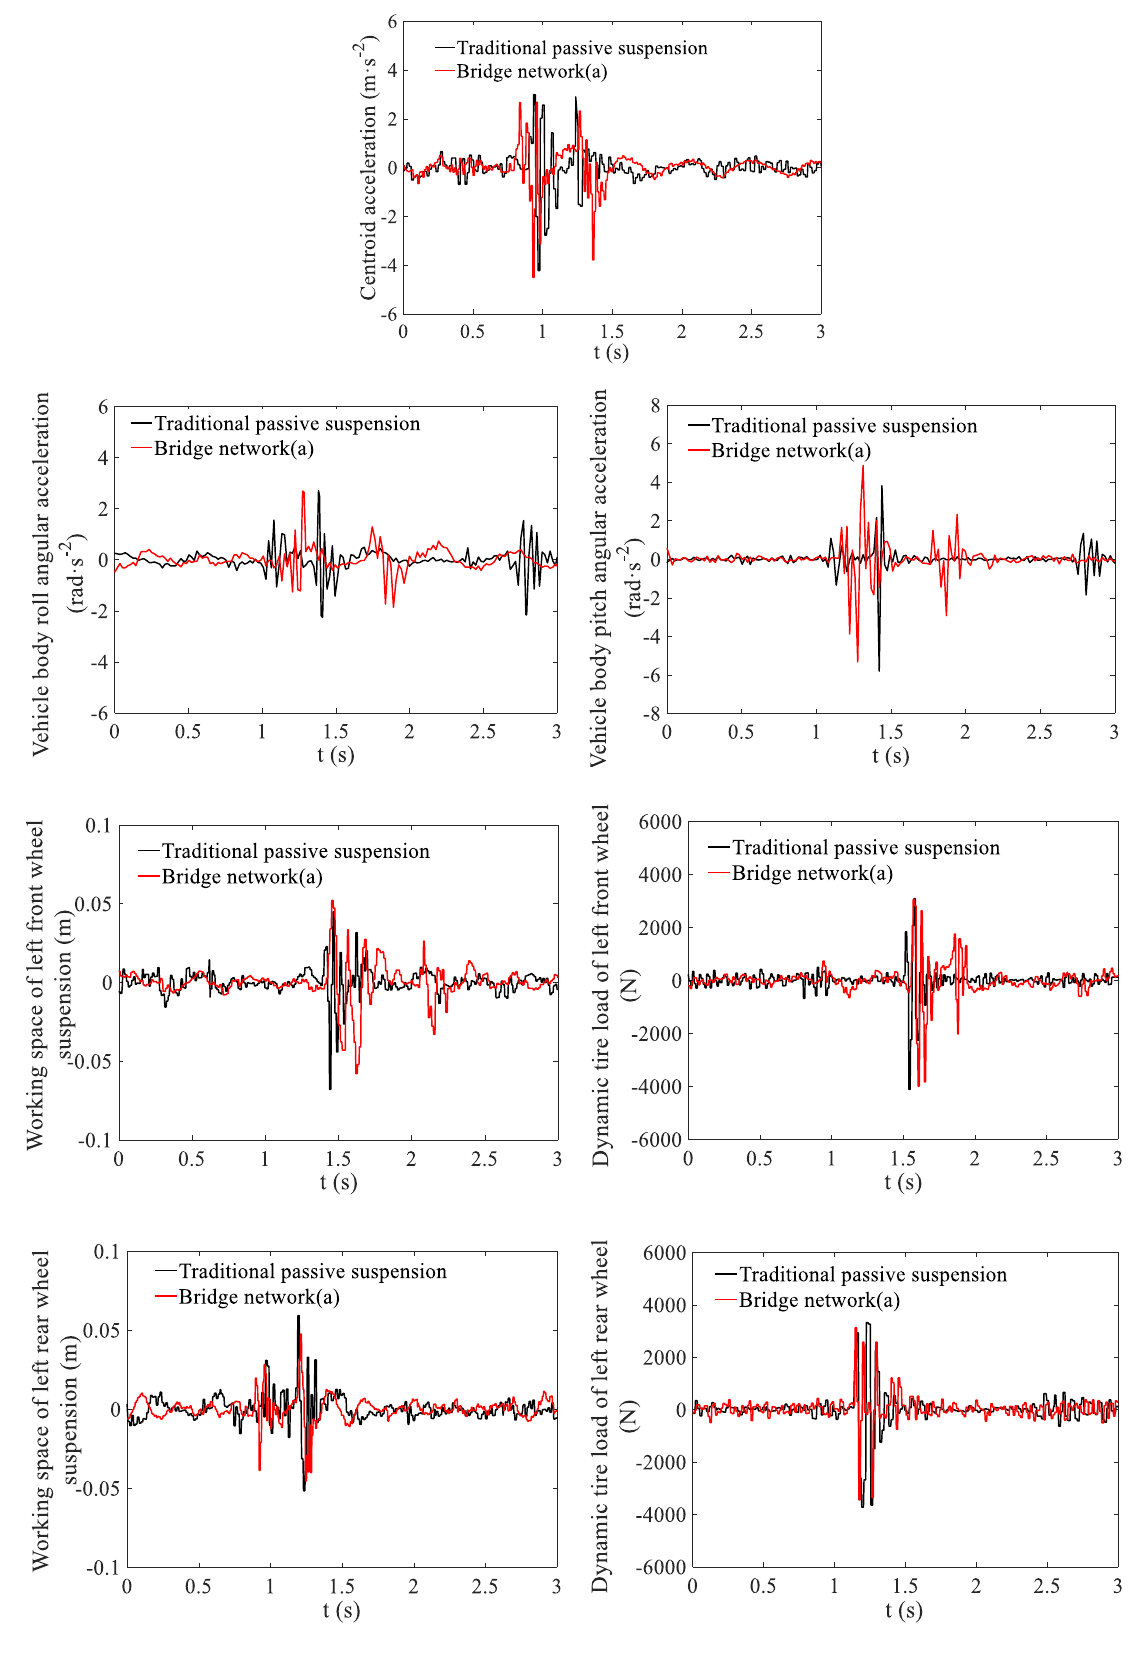
Figure 9. Comparison diagram with a pulse road input with a vehicle speed of 20 km/h.